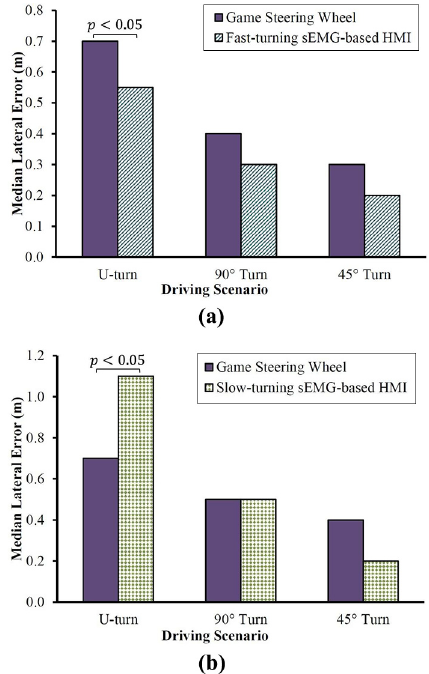
Figure 9 Comparison of steering interfaces with respect to median